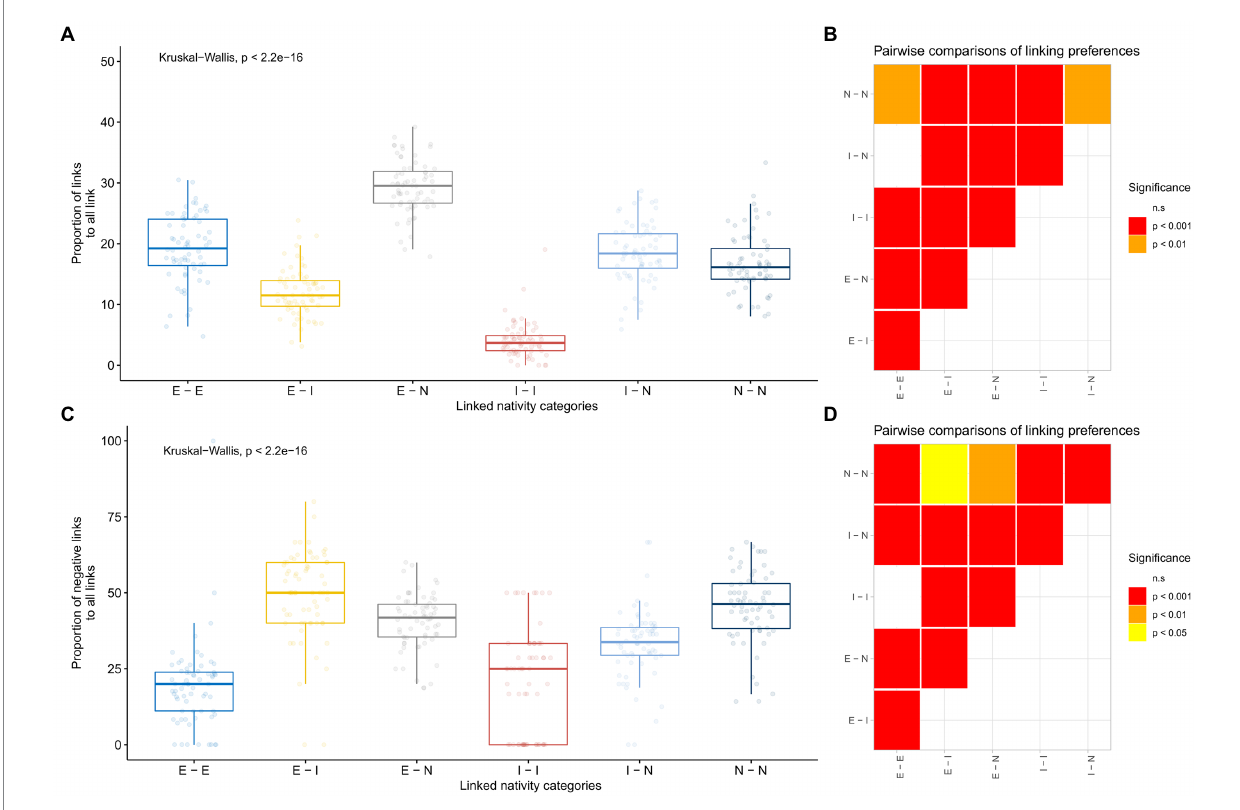
FIGURE 4 Preferential linking between endemic, native, and exotic species. The distribution of the proportion of both positive and negative links (A) , and negative links only (C) to all links between nativity category pairs. Pairwise comparisons using pairwise Wilcox tests are shown on the right side ( B,D , respectively). All p -values of pairwise Wilcox tests are adjusted according to the FDR